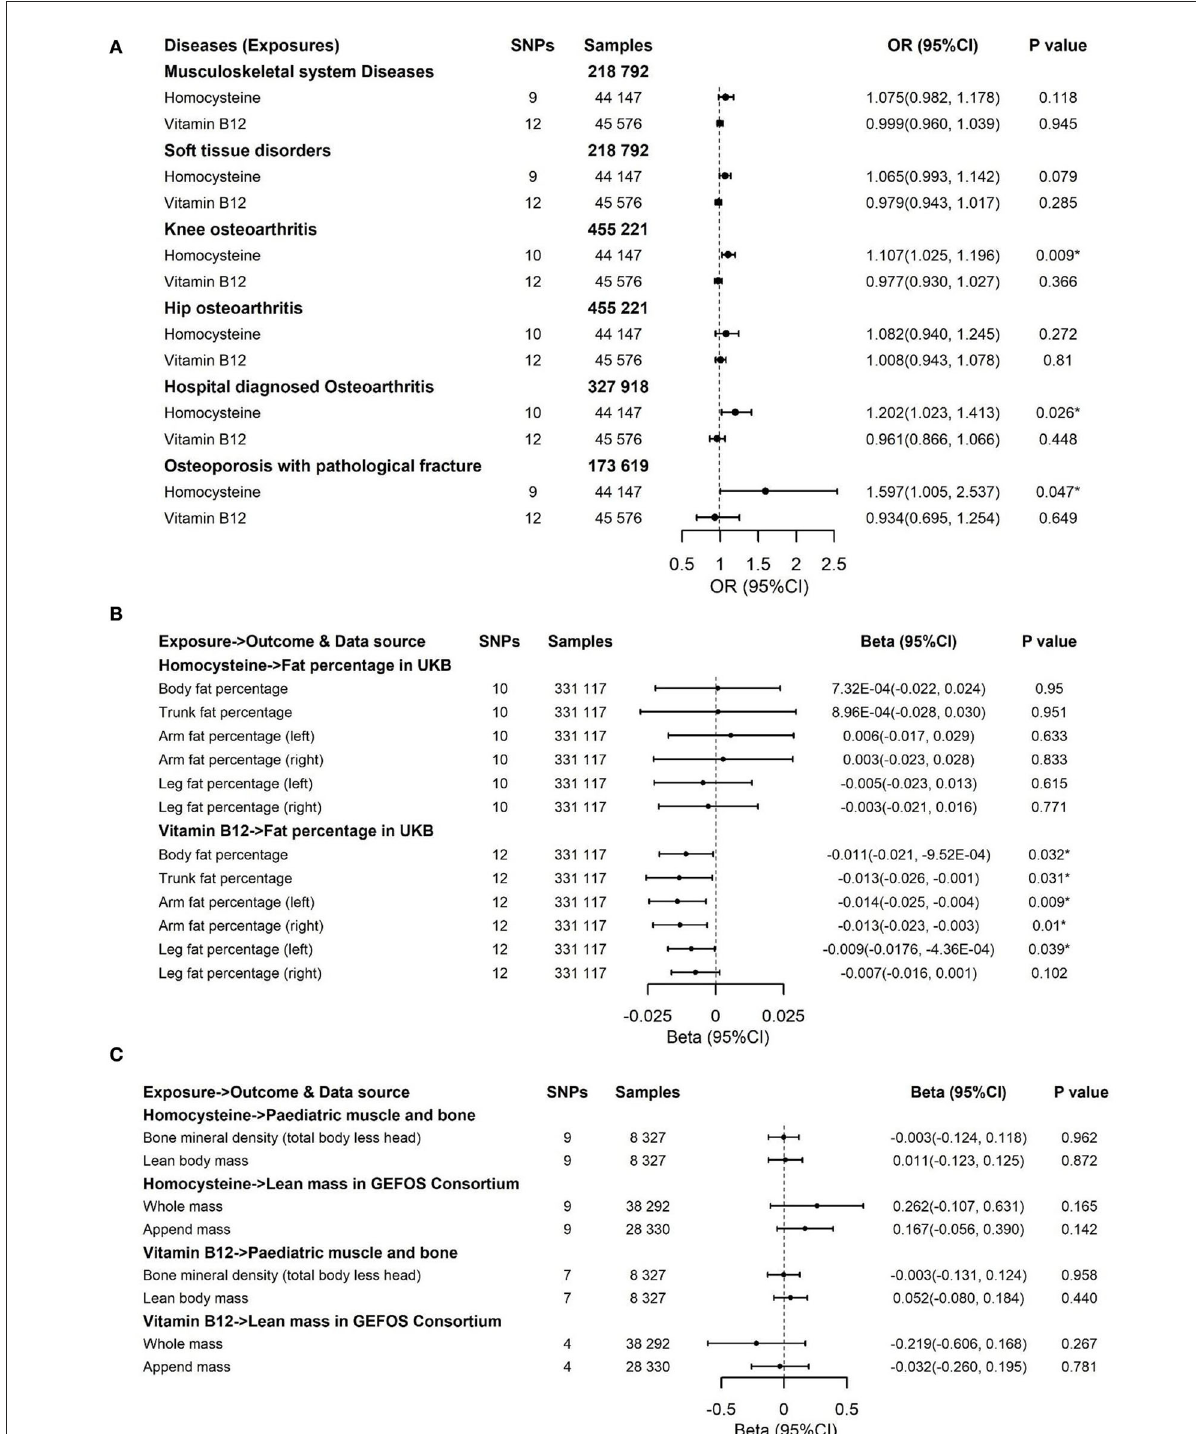
FIGURE5 Effects of genetically predicted circulating homocysteine and vitamin B12 on musculoskeletal system diseases, soft tissue disorders, knee osteoarthritis, hip osteoarthritis, hospital-diagnosed osteoarthritis, and osteoporosis with pathological fracture (A) , fat percentage (B) and lean mass (C) via IVW method in the sensitivity analysis with exclusion of 4 pleiotropic SNPs for homocysteine and one pleotropic SNP for vitamin B12. CI, confidence interval; GEFOS, GEnetic Factors for OSteoporosis Consortium; The summary statistics data of UKB can be downloaded from Nealelab (http://www.nealelab.is/uk-biobank); The summary statistics data in FinnGen Consortium can be downloaded from Google cloud storage free of charge (https://www.finngen.fi/en/access_results). * P value reached the significant level; SNP, single nucleotide polymorphism; IVW, inverse variance weighted